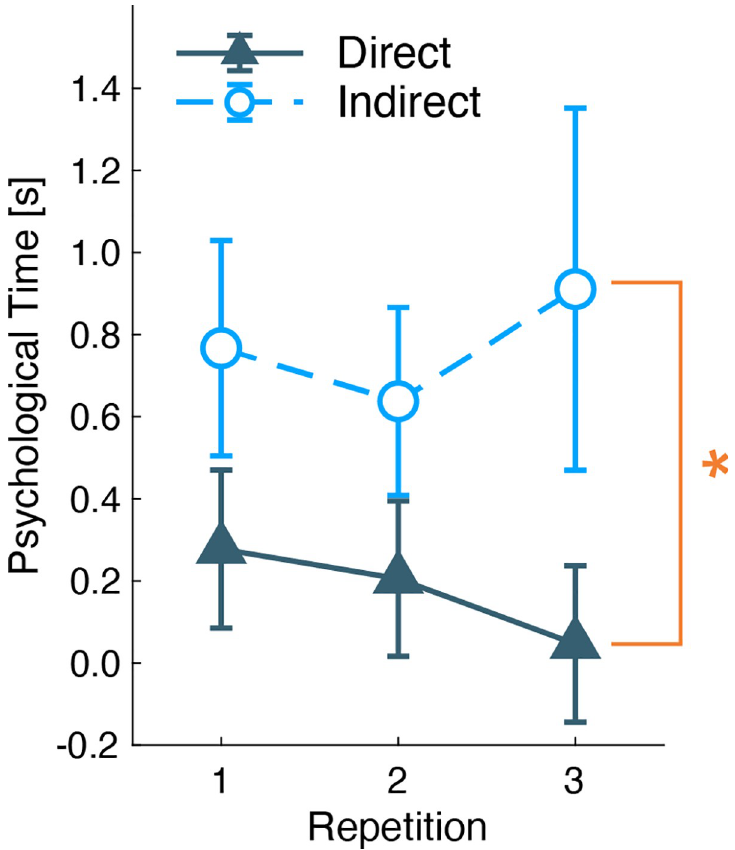
Fig 9. Mean and standard errors of the psychological time. The Y-axis indicates the psychological time, which is the difference between the mean response time in CM and CA. The X-axis indicates three repetitions of the measurements. The U-shaped line with an asterisk shows significant main effects of the airflow condition obtained by two-way ANOVA. ( � : P < 0.05).